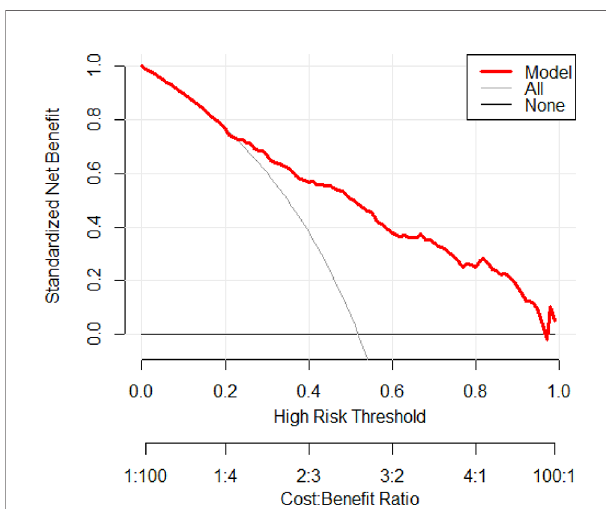
FIGURE 4 | Decision curve analysis was exhibited to estimate the clinical usefulness of the nomogram (PCa). The quanti fi ed net bene fi ts can be measured at different threshold probabilities. The y-axis denotes the standardized net bene fi t, and the x-axis denotes the threshold probabilities. The red line represents our nomogram, the gray line represents the condition that all patients have PCa, and the black line represents the condition that none have PCa.